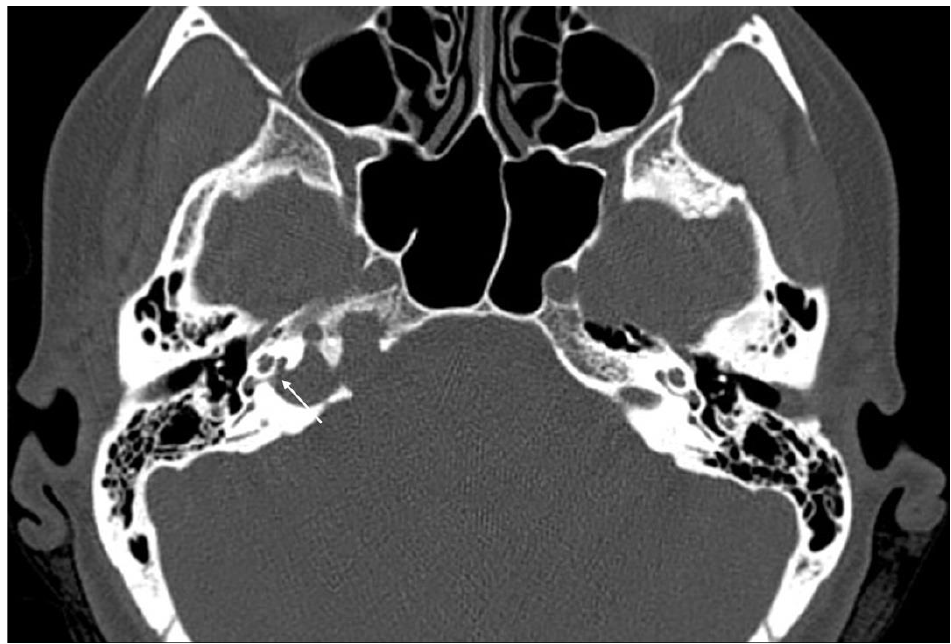
Figure 4. Axial CT scan showing erosion of the right cochlear basal turn (white arrow) by a choles- terol granuloma.